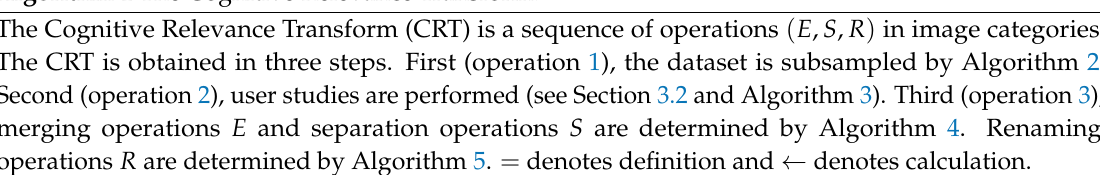
Algorithm 1 The Cognitive Relevance